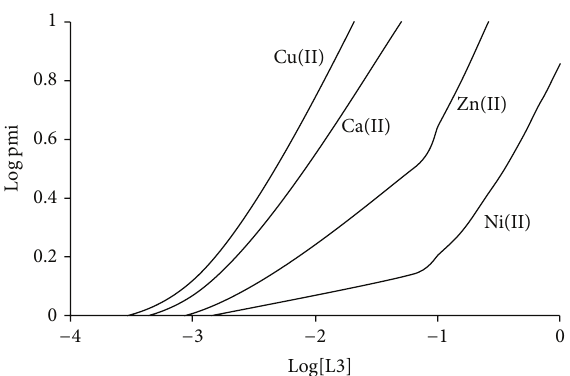
Figure 5: Logarithms of Cu(II), Ni(II), Zn(II), and Ca(II) plasma mobilizing index plotted against log [ L 3]